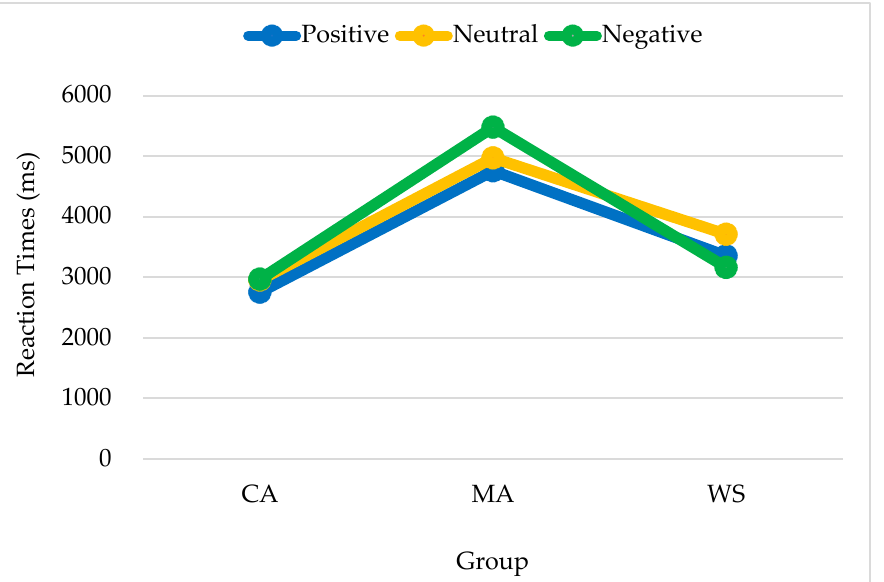
Figure 4. Reaction times of the responses to positive primes by emotion target type and group. Note. CA, chronological age-matched controls; MA, mental age-matched controls; WS, participants with Williams syndrome.